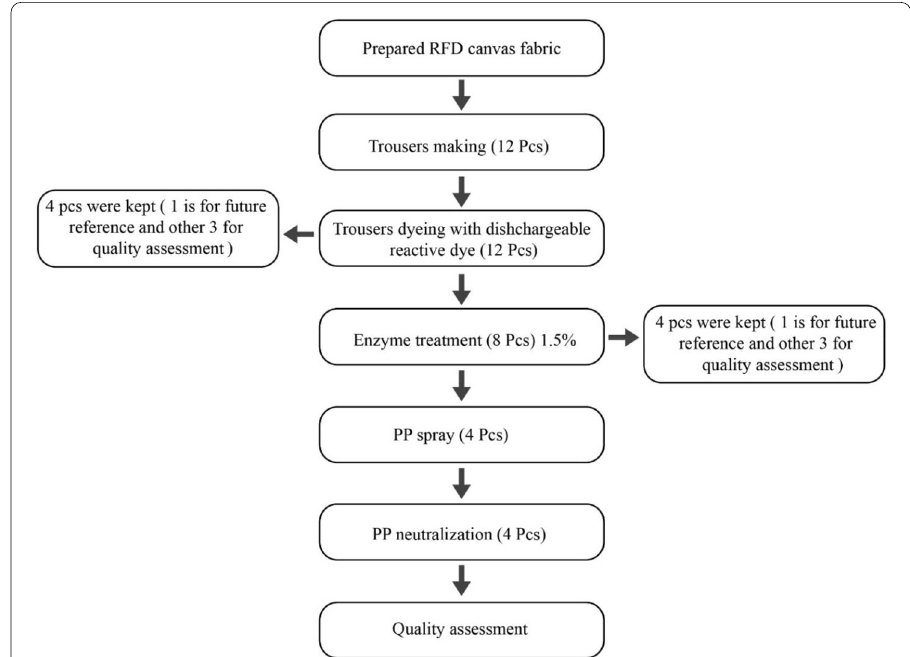
Fig. 1 Process sequence of research methodology